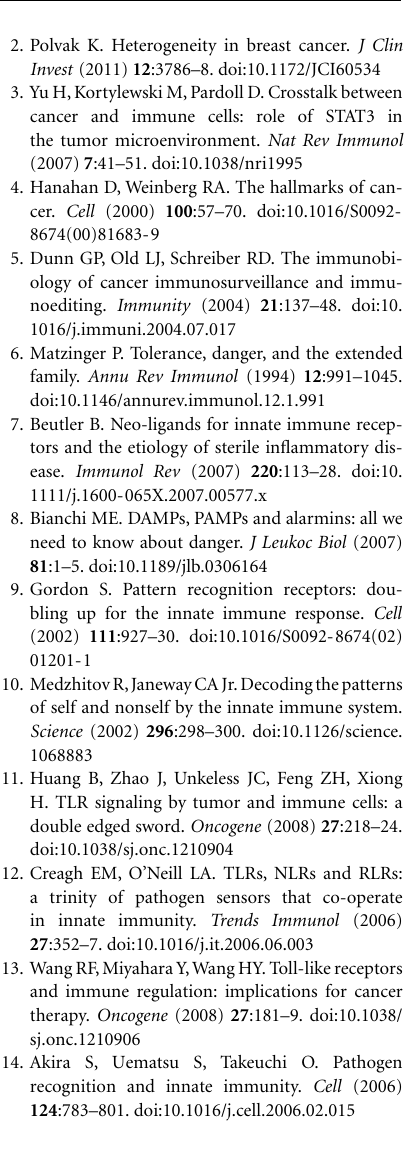
breast cancer cells (39). Inflammatory